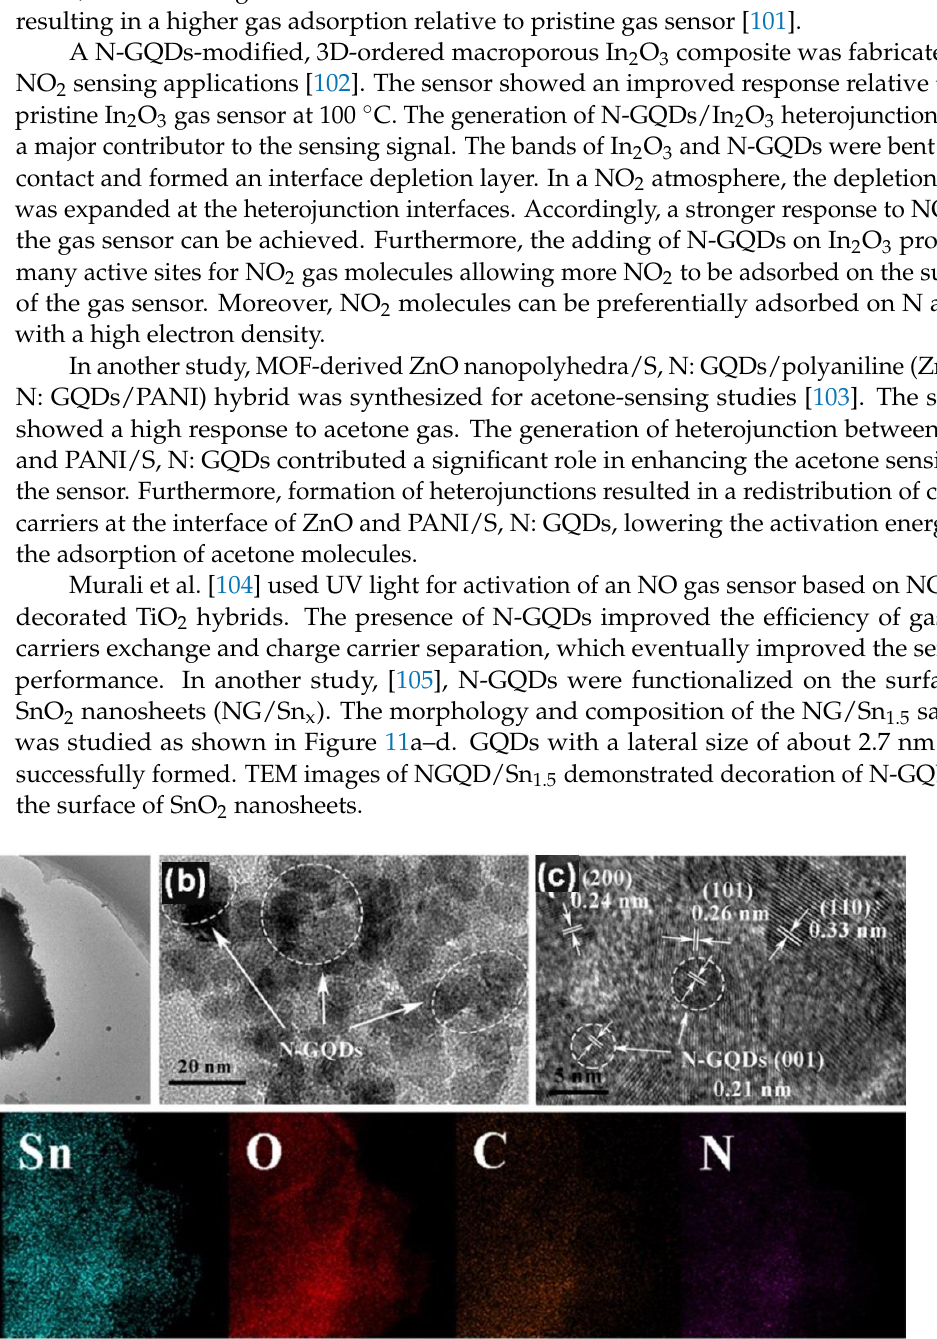
Figure 12. ( a ) Responses of SnO 2 and NGQD/Snx at various temperatures for 1 ppm NO 2 ; ( b ) long- term stability of NGQD/Sn 1.5 sensor to 1 ppm NO 2 in 45 days [105]. Due to formation of heterojunctions, the sensor showed a more resistance change compared to pure sensor, and a higher NO 2 response was recorded. Furthermore, NGQDs have a strong interaction with NO 2 due to more negative adsorption energy. Also, doped N atoms with high electron density provided plenty of adsorption sites for NO 2 with strong electrophilic ability. Moreover, the higher electronic partial density of states caused by N doping was beneficial to the electron transfer in the NO 2 sensing process. Finally, mesopores nature of gas sensor provided many diffusion channels, leading to rapid ad- sorption of NO 2 . Hu et al. [106] fabricated GQDs (2 –4 nm)/α - Fe 2 O 3 composite gas sensor for trimethyl- amine (TMA) gas sensing. The responses of the sensor to 1000 ppm TMA gas was 1033.0 at 270 °C, which was 187.8 times larger than that of pristine α -Fe 2 O 3 gas sensor. The sensor also showed a good selectivity to TMA gas. The electron cloud density around N atom in TMA is high; thus, the attractive force between N atom in TMA and Fe 3+ ion on the surface of the composite facilitated the adsorption of TMA gas. In addition, the bond strengths of C – H, C – C, C – N, C=O, and O – H are 411, 345, 307, 748.2, and 462 KJ/mol, respectively. Thus, the bond energy of C – N in TMA was low, leading to good selectivity of the sensor to TMA. In another work [107], a boron-doped GQD (BGQD)/Ag-LaFeO 3 p-p sensor was developed for benzene sensing. The sensor exhibited a high response of 17.5 to 1 ppm